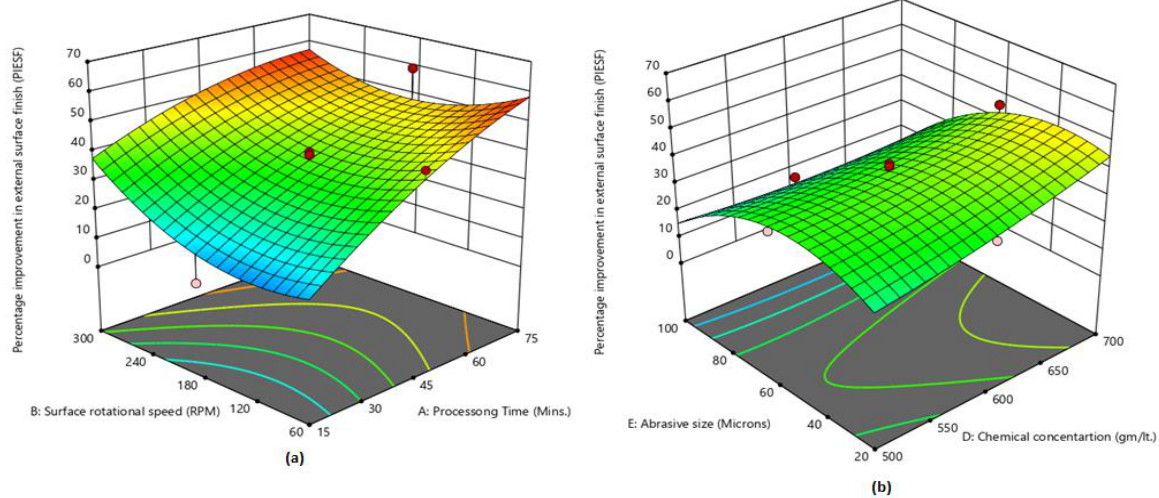
Figure 5. ( a ) Influence of processing time and rotational speed on PIESF; ( b ) influence of abrasive size and chemical concentration on PIESF. size and chemical concentration on